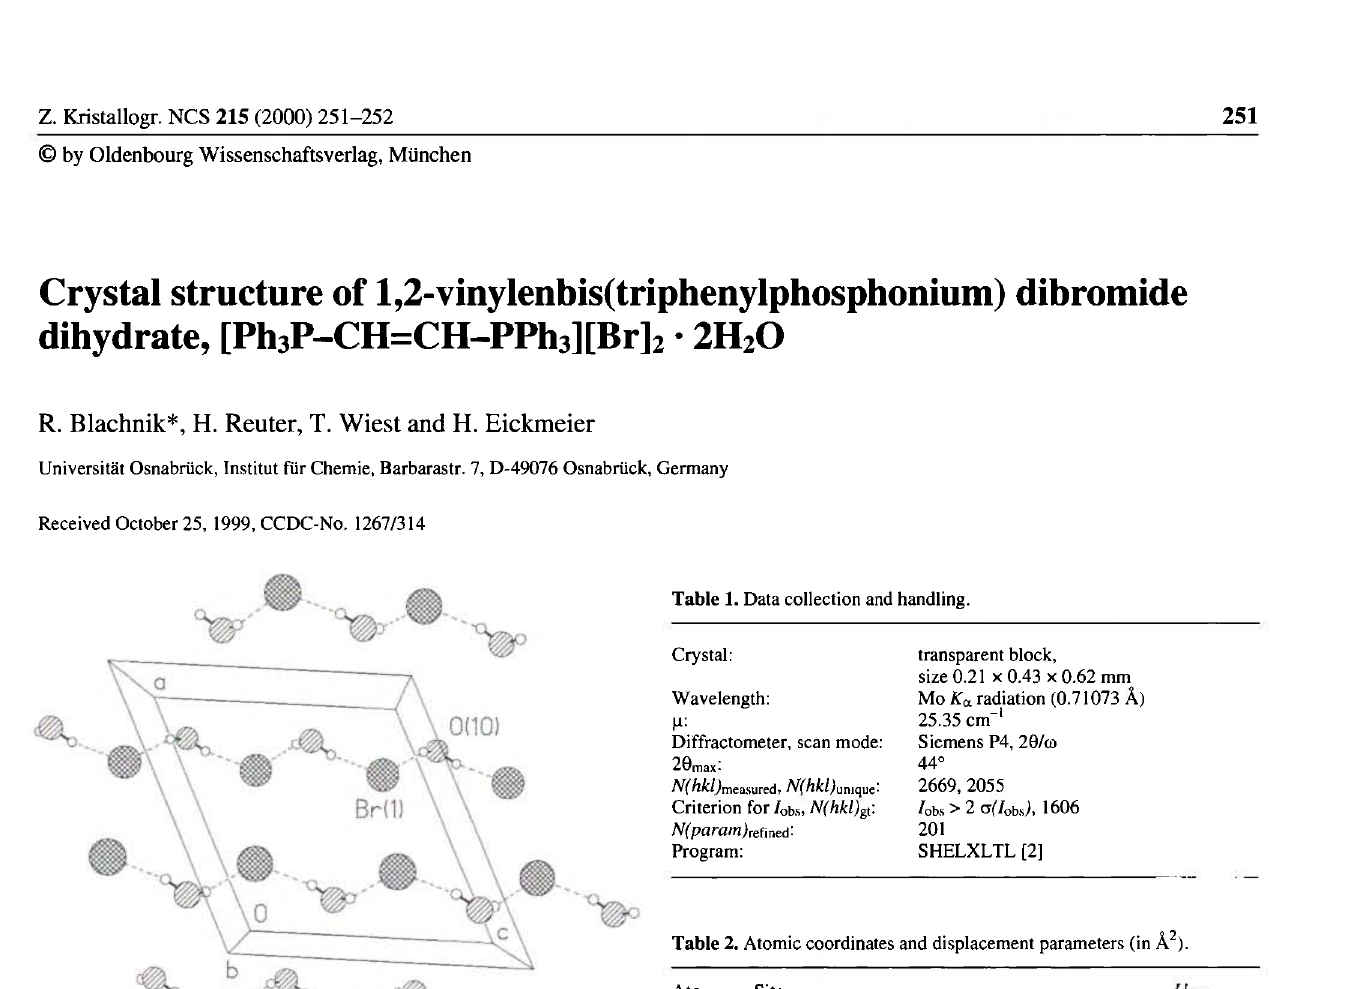
Table 2. Atomic coordinates and displacement parameters (in Ä 2